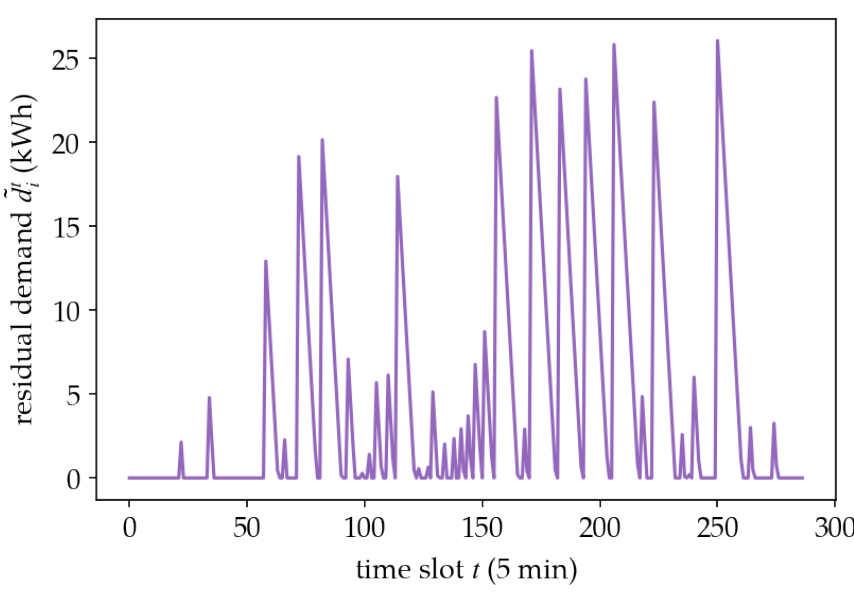
Figure 14. Residual demand for a single